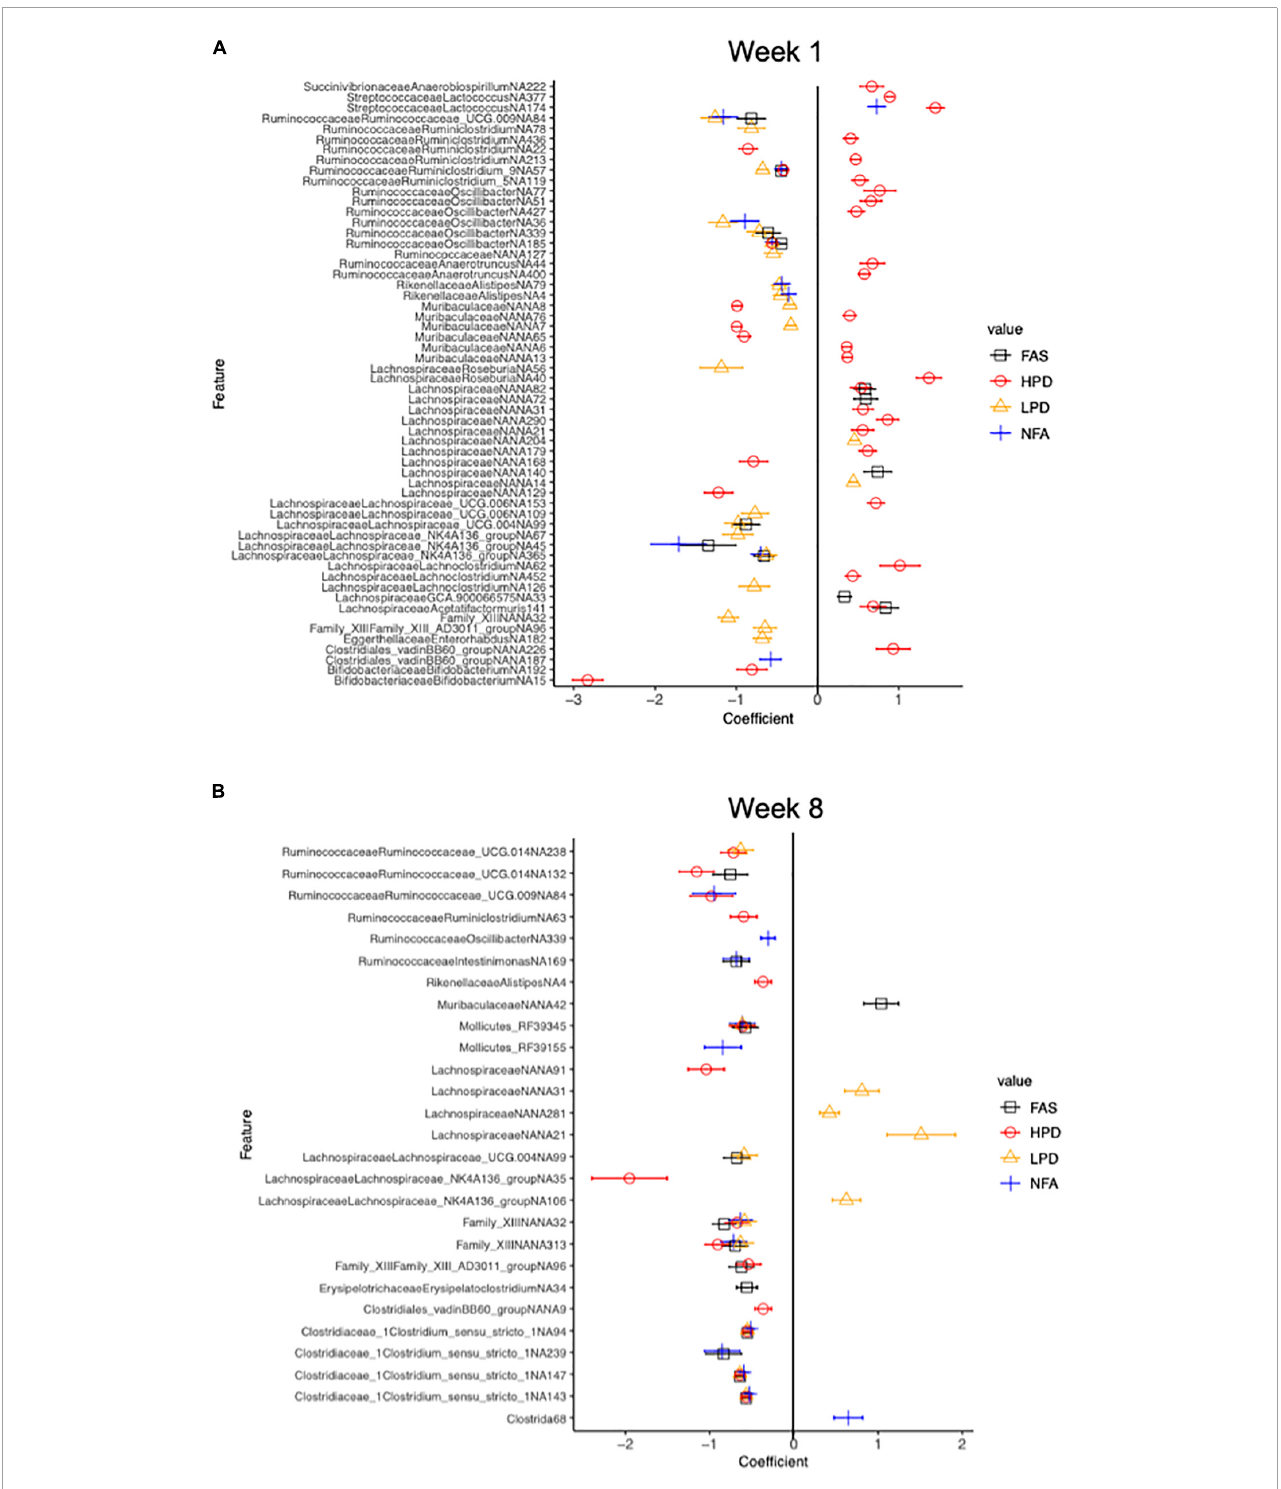
FIGURE7 Differential relative abundance analysis relative to the control diet group (FPC) at 1 week and 8 weeks. Counts were transformed to relative abundance prior to analysis. The top 50 and top 52 ASVs are reported in panels (A,B) , respectively. ASVs in panel (A) all have a q value less than 0.006 and in panel (B) , a q value less than 2.53e-0.02 (Benjamini-Hochberg adjustment). The control (FPC) group is used as the reference group with FAS, HPD, LPD, and NFA being compared to this group. ll coefficients for these groups are relative to 0. A negative coefficient implies a decreased abundance of that taxon and a positive coefficient implies an increased abundance of that